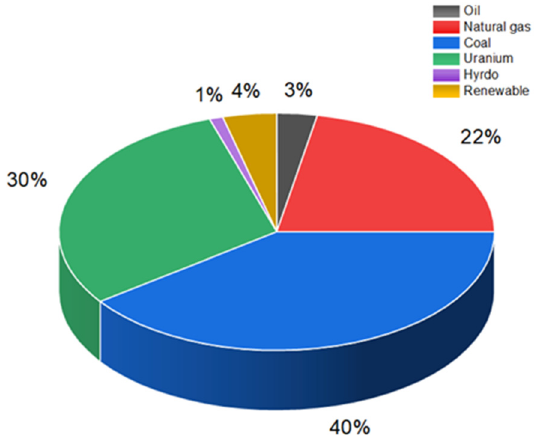
Figure 8. Energy sources for the electricity grid of South Korea [31].